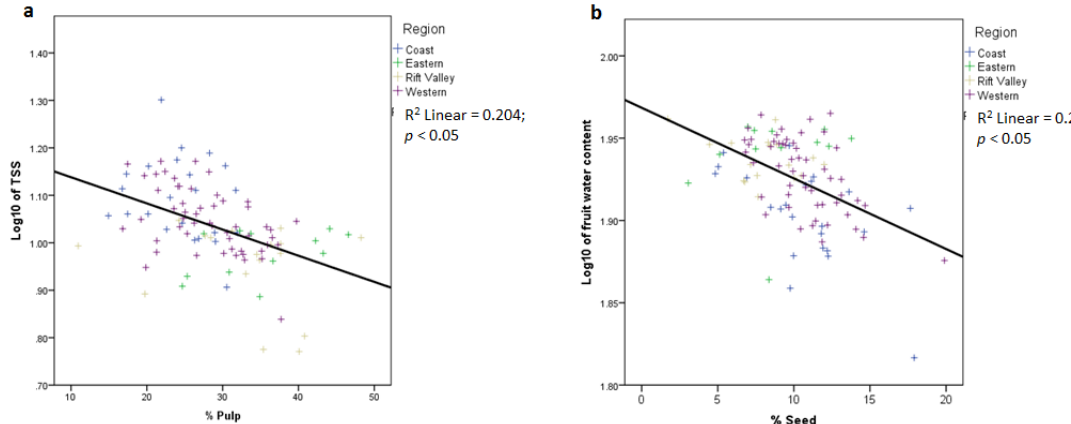
Fig. S3: Pearson correlation between (a) pulp proportion and TSS of 105 guava fruit samples from four regions of Kenya, and between (b) seed proportion and fruit water content of 105 guava fruit samples from four regions of Kenya. TSS was determined on extracted juice from edible portion of the fruit, and water content was determined as the difference between freeze-dried and fresh sample weights. Pulp proportion (% pulp), and seed proportion (% seed) are based on weight of the entire fresh fruit (g).